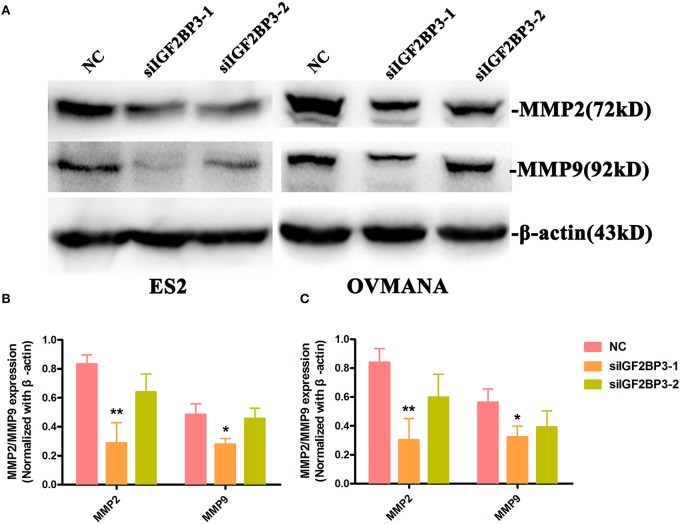
The effect of siIGF2BP3 on MMP2 and MMP9 protein expression in both ES2 and OVMANA cells. (A) Western blotting analysis of MMP2 and MMP9 protein in ES2 (Supplementary Figure 4) and OVMANA (Supplementary Figure 5) cells. (B,C) Relative expression levels of MMP2 and MMP9 protein in ES2 (B) and OVMANA (C) cells. Results were obtained from three independent experiments. MMP2 and MMP9 expression level comparison, *p < 0.05, **p < 0.01.